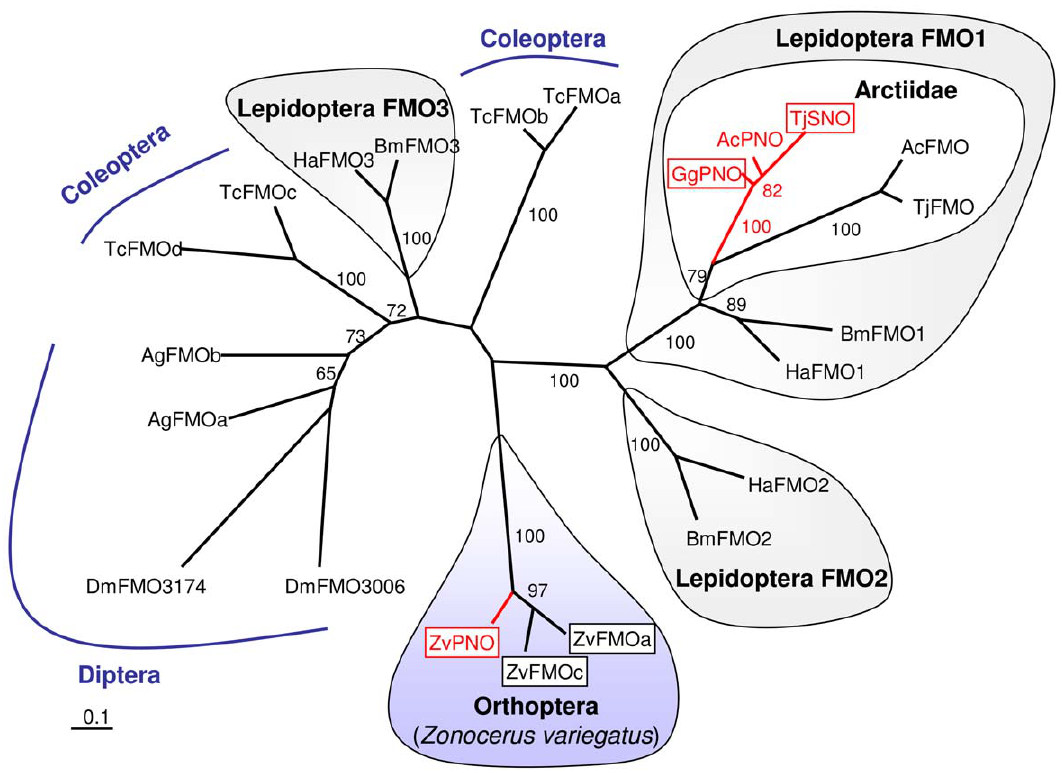
Figure 2. Unrooted maximum-likelihood tree of amino acid sequences derived from cDNA encoding FMOs of various insect species. Framed sequences were heterologously expressed and functionally analyzed. The other sequences should be regarded as putative FMO- coding cDNA. Branch lengths are proportional to the number of amino acid substitutions per site (scale: 0.1 substitutions per site). Bootstrap proportions resulted from 1000 replicates and are given for values . 50. Ac , Arctia caja ; Ag , Anopheles gambiae ; Bm , Bombyx mori ; Dm , Drosophila melanogaster ; Gg , Grammia geneura ; Ha , Helicoverpa armigera ; Tc , Tribolium castaneum ; Tj , Tyria jacobaeae; Zv , Zonocerus variegatus . Accession numbers for all sequences are listed in Figure S1.